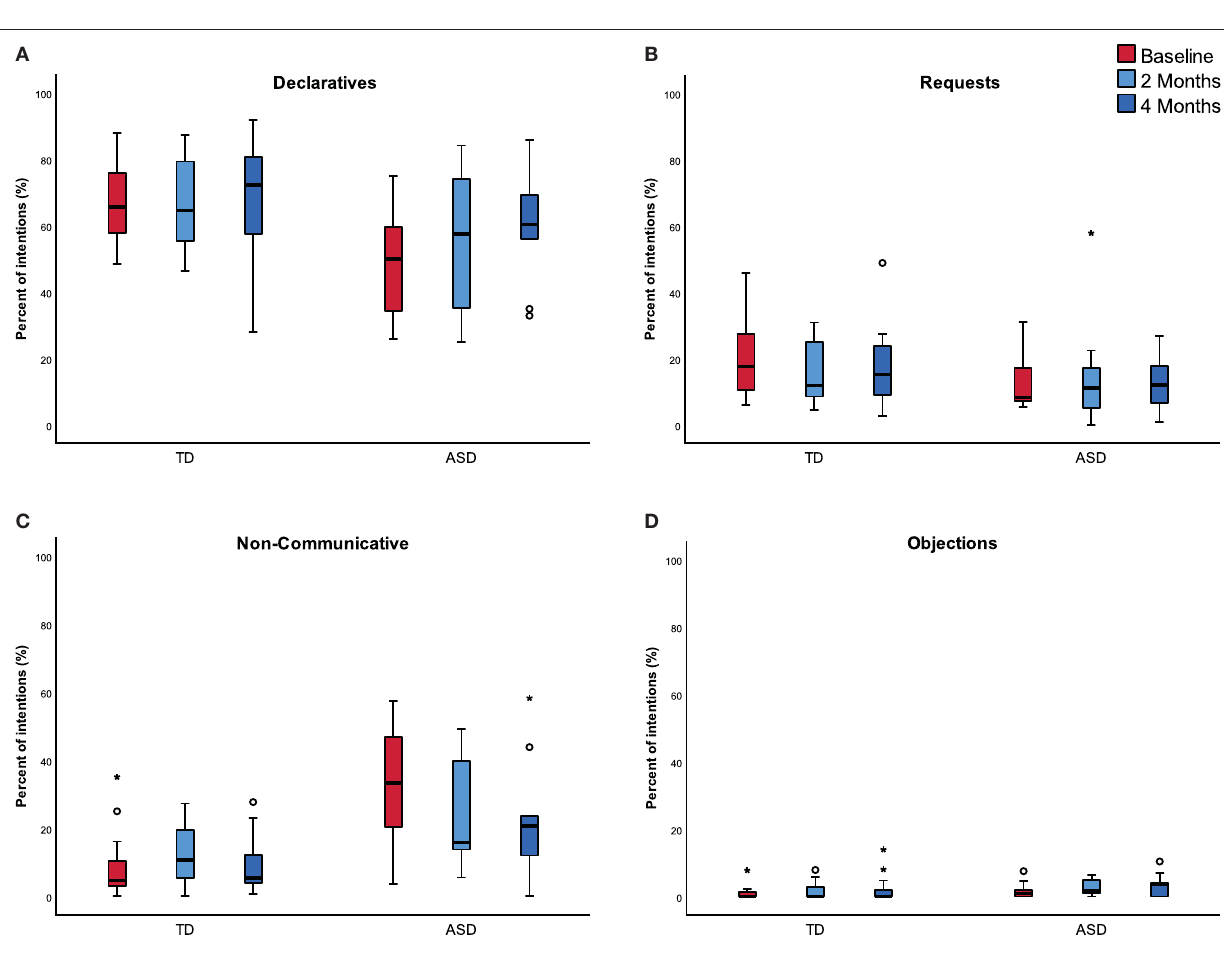
FIGURE 2 | Proportion of communicative intentions in each group across three visits. In (A) declaratives, (B) requests, (C) non-communicative, and in (D) objections.